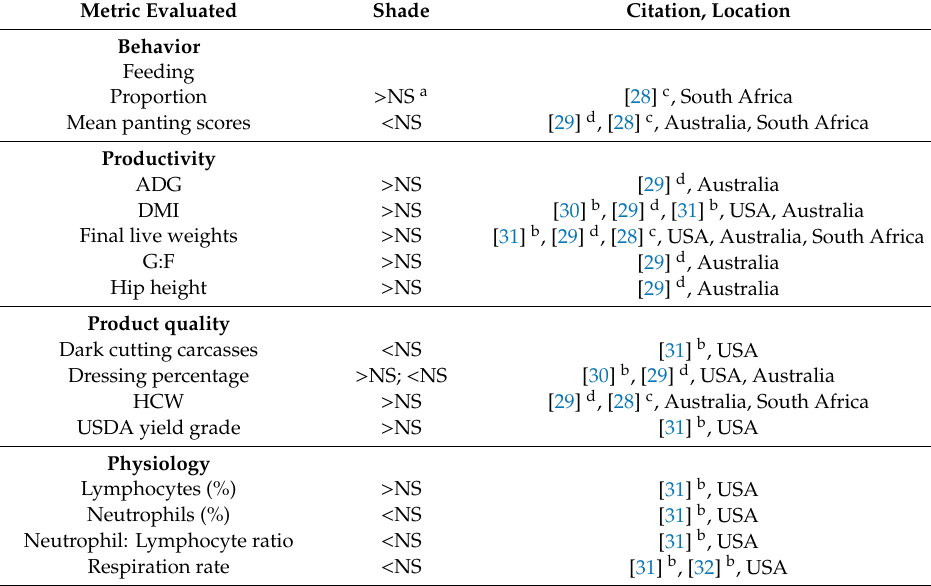
Table 6. Overview of the e ff ect of shade on beef cattle behavior, productivity, product quality and physiology. Studies are reported in the same language as they were presented by original study authors. Inclusion of significant results was determined at p <